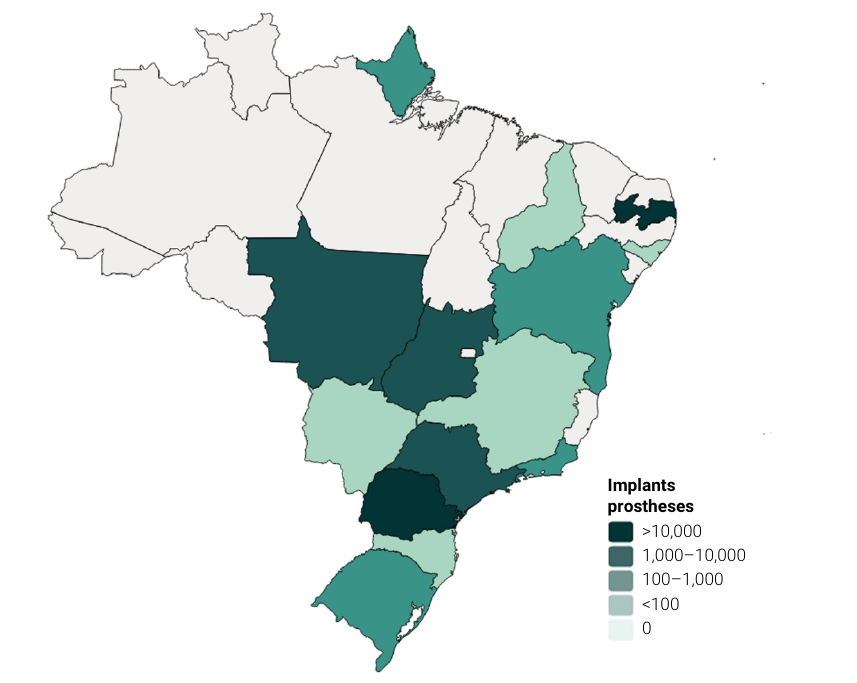
Figure 2. Heat-map of the distribution of implant-retained prostheses provided by SUS for each Brazilian